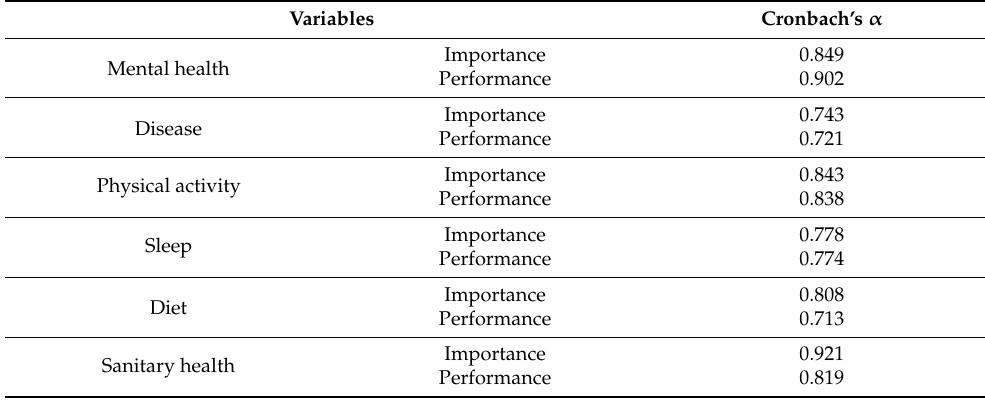
Table 2. Reliability